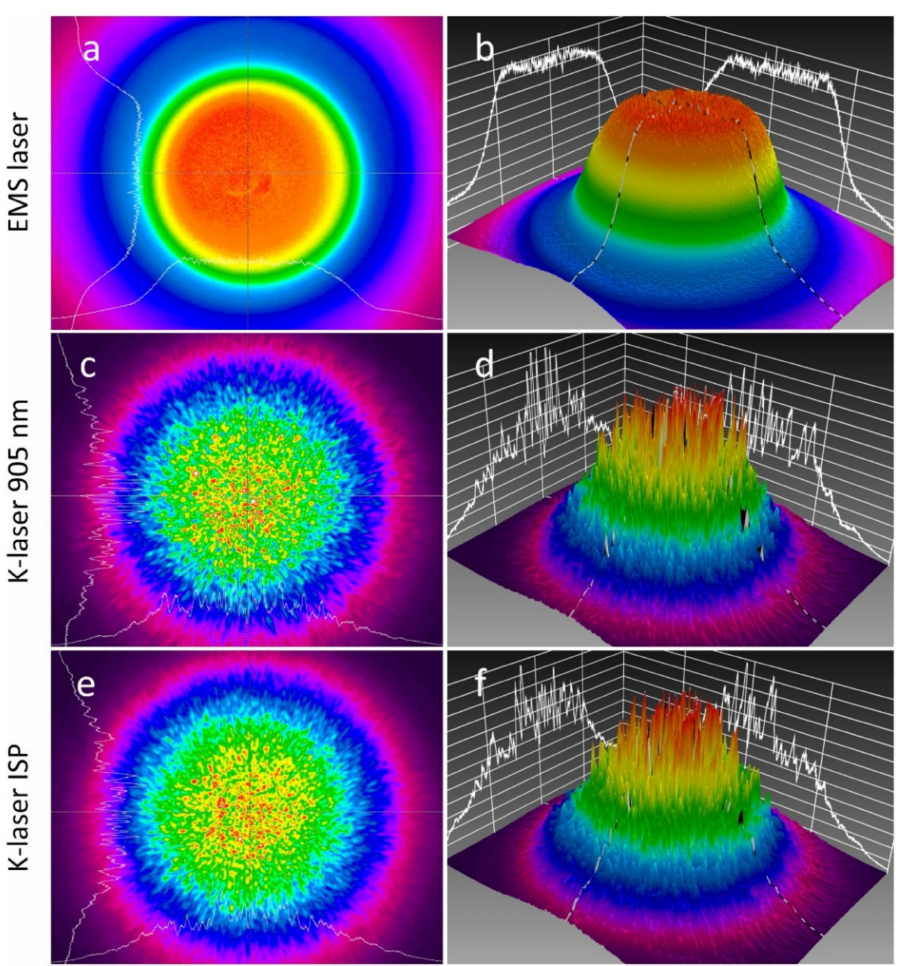
Figure 2. Power density maps recorded with a beam profiling camera for the EMS laser ( a , b ), the K-laser using 905 nm wavelength ( c , d ), and the K-laser operated in ISP mode ( e , f ). Two-dimensional power density maps ( a , c , e ) are shown as well as three-dimensional representations ( b , d , f ). White lines in both representations are beam profiles along the x- and y-axis. Maps were normalized to the maximum intensity of each